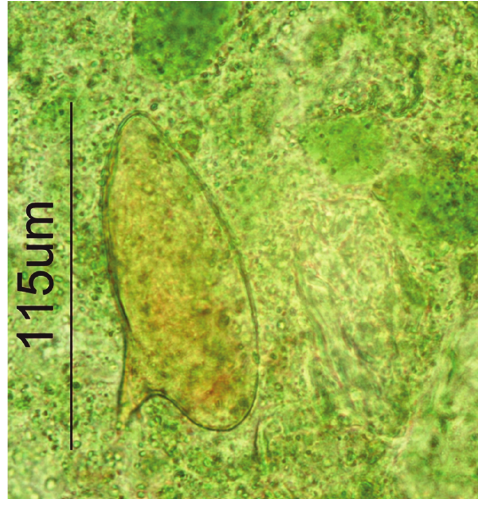
Figure 1: Schistosoma mansoni eggs detected by Kato-Katz method from patient’s